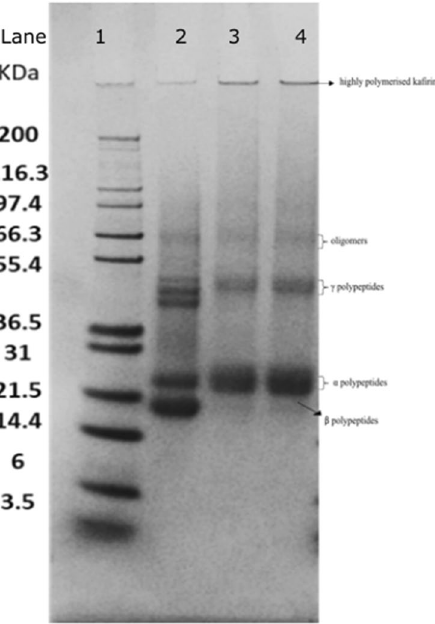
Figure 1. Sodium dodecyl sulphate—polyacrylamide gel electrophoretograms of proteins under non reducing conditions. Lane 1: protein molecular weight marker; Lane 2: zein internal control; Lane 3: sorghum grain kafirin; Lane 4: kafirin from sorghum dried distillers grain with solubles (DDGS). This is an image of a single full gel representative of the